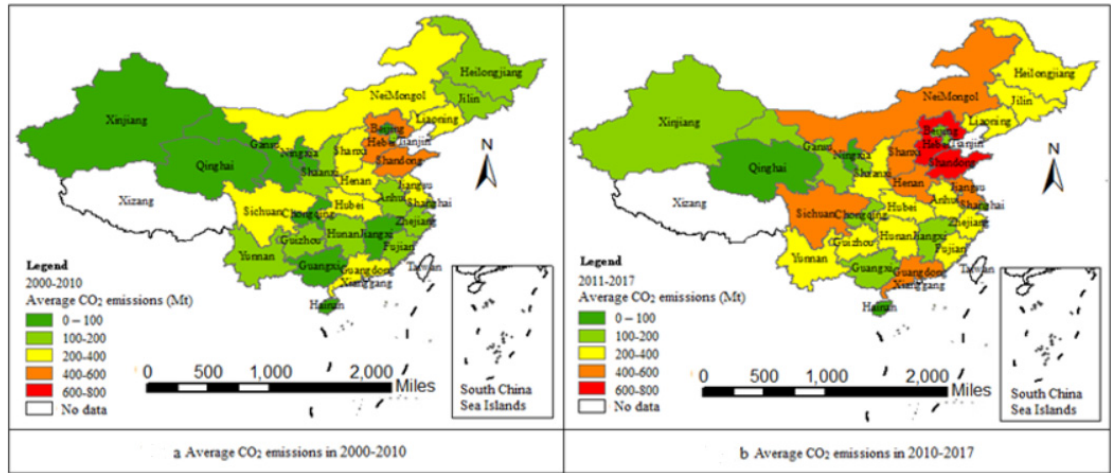
Figure 1. Spatial pattern of provincial CO 2 emissions (Mt) during ( a ) 2000–2010 and ( b ) 2010–2017.